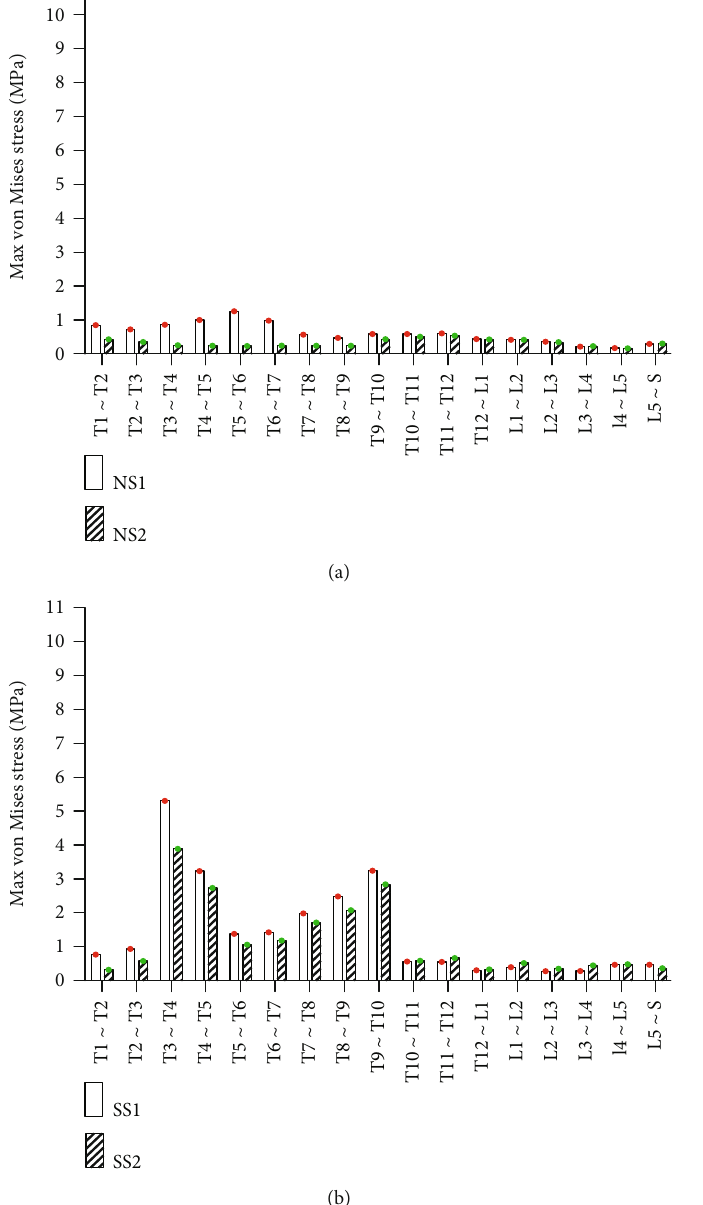
Figure 13: Stress distribution of disc in four spinal models under vertical compression: (a) stress distribution of normal spinal intervertebral discs; (b) stress distribution of scoliotic spinal intervertebral discs. NS1, NS2, SS1, and SS2 need to be de fi ned